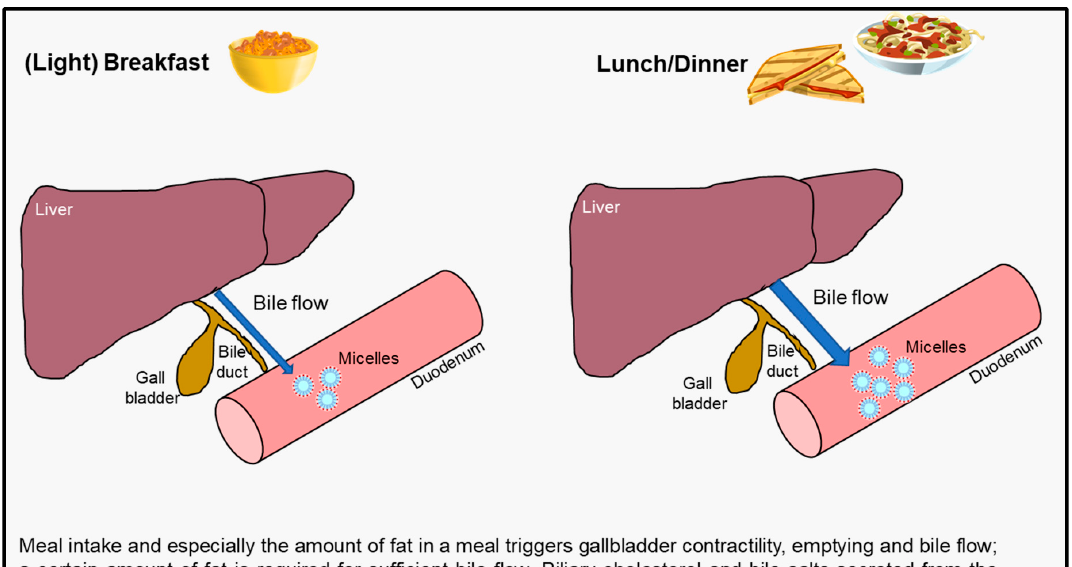
Figure 2. The impact of meal intake on gallbladder contractility and bile flow affecting micelle formation in the gut. formation in the